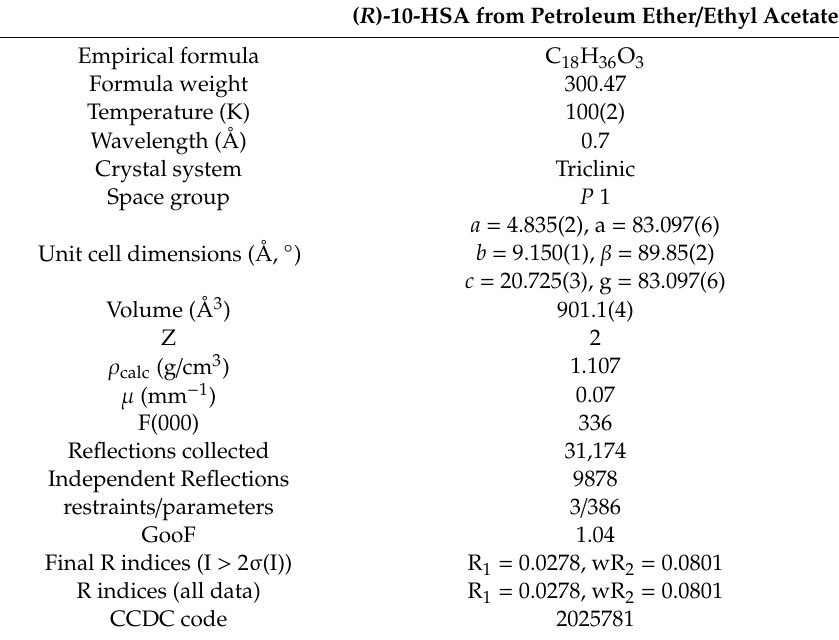
Table 2. Crystal data and structure refinement for ( R )-10-HSA, crystallized from a mixture of petroleum ether and ethyl